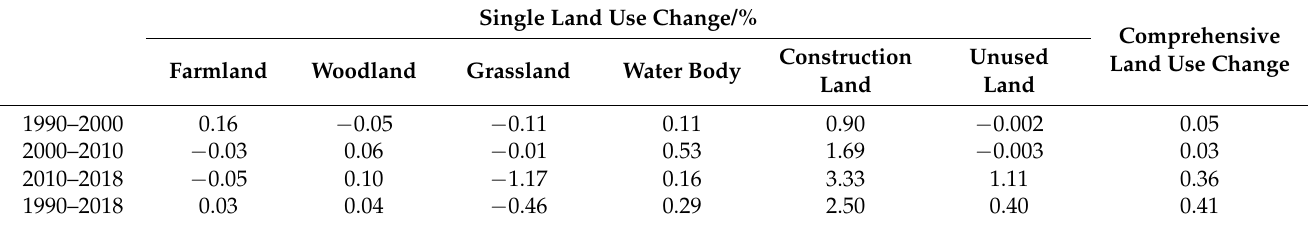
Table 4. Dynamic changes of land use in China from 1990 to 2018 (%).